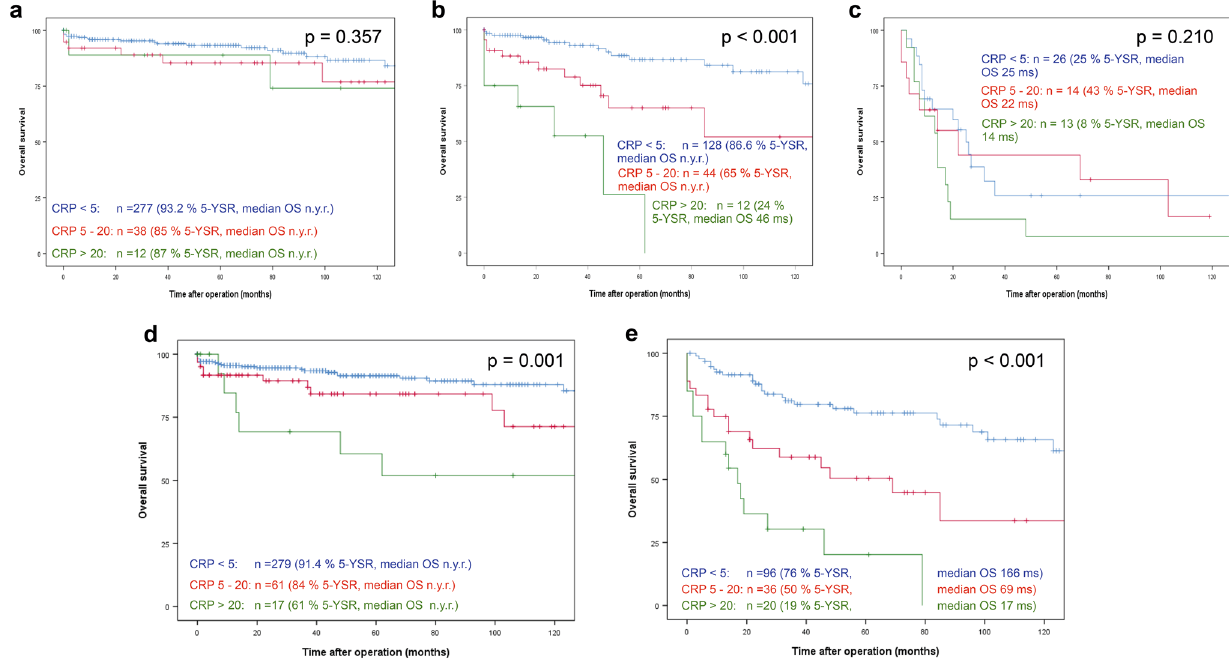
Figure 2. Association of tumour differentiation and stage with survival in serum CRP subgroups. Overall survival rate of resected pNEN patients stratified by serum CRP levels in G1 (a) , G2 (b) and G3 (c) differentiated tumours as well as in pT1 & pT2 (d) and pT3 & pT4 tumours (e). G1: Ki-67 ≤ 2%; G2: Ki-67 3–20%; G3: Ki-67 > 20%; group 1: CRP < 5 mg/l; group 2: CRP 5-20 mg/l; group 3: CRP > 20 mg/l. Patients